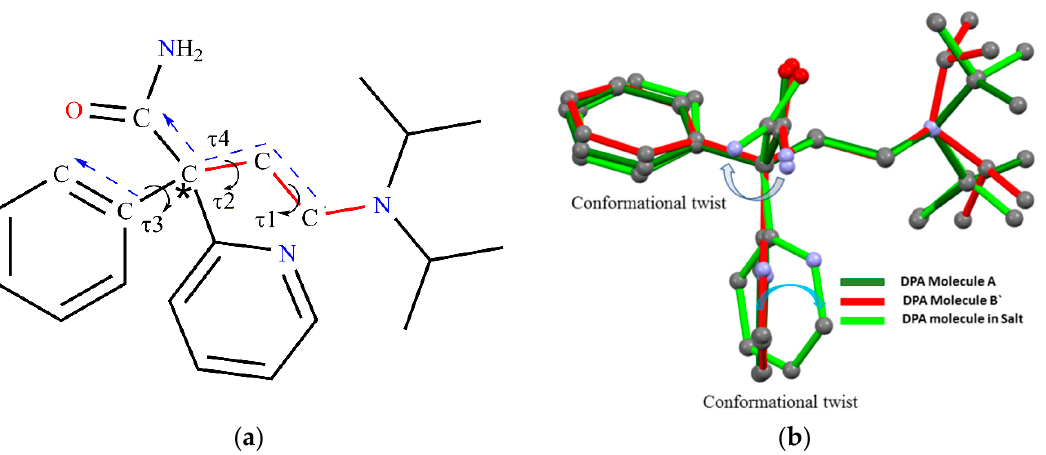
Figure 12. ( a ) Chemical structure of DPA, in which the (C-C-C-N) backbone chain is marked by a red color bond and ( b ) Structural overlay of DPA molecules in both solid forms showing significant conformational variation; Green-Molecule A, Red-Molecule B` in DPA, Light green-DPA molecules from DPA_PA salt. Table 3. Torsional/dihedral angle in DPA and DPA_PA.